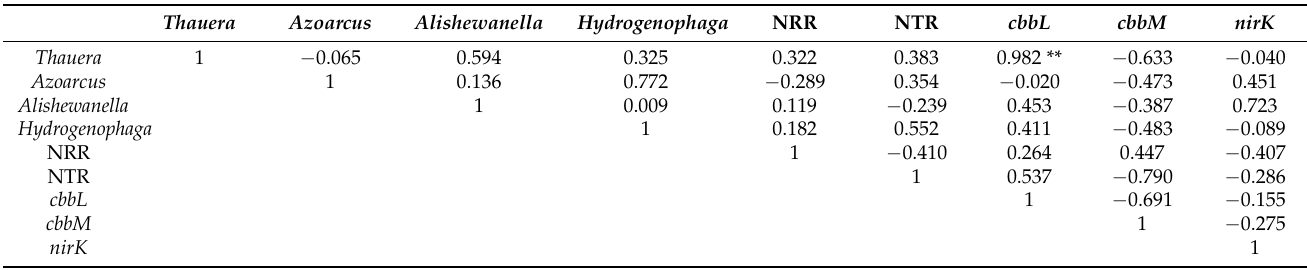
Table 2. Pearson correlation between NRR, NTR, functional bacteria and functional